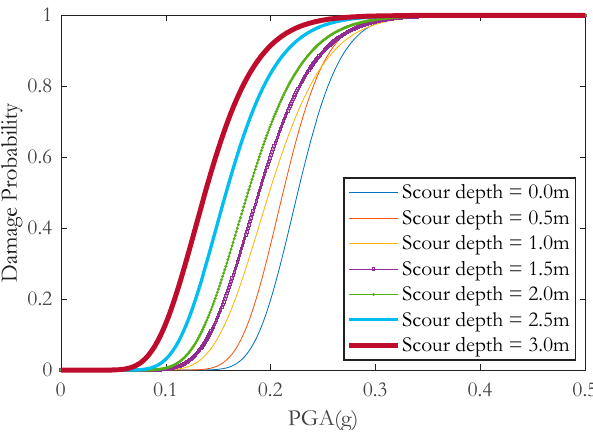
Figure 9. Change in the fragility curves caused by scour effects at moderate damage state.